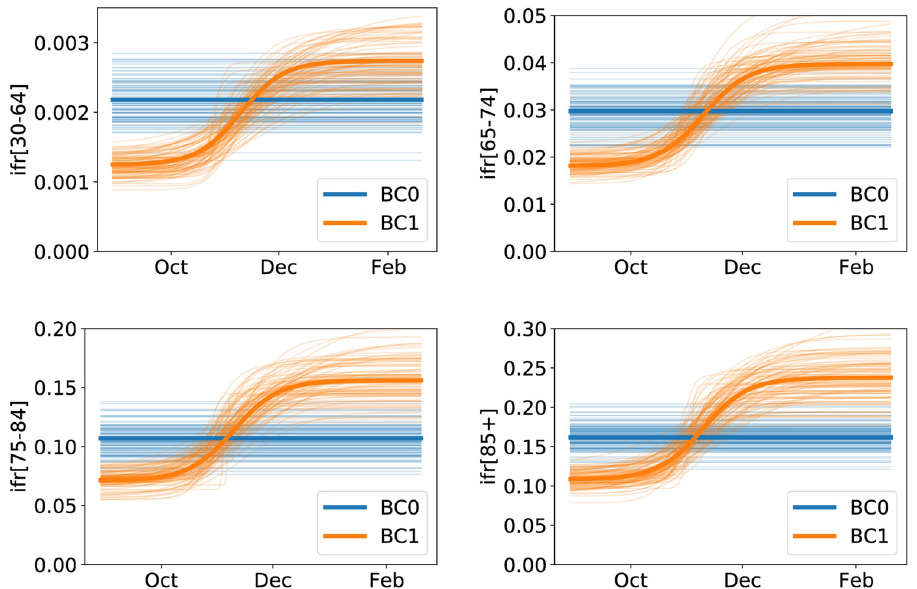
Fig 7. Inferred changes of the IFR. We show data for model variants BC0 (blue) and BC1 (orange, time-dependent), for four different age groups (indicated in square brackets). The thick lines represent the IFR determined from the MAP parameters, the thin lines correspond to 100 samples of the parameters for the IFR drawn from the Gaussian approximation of the posterior.